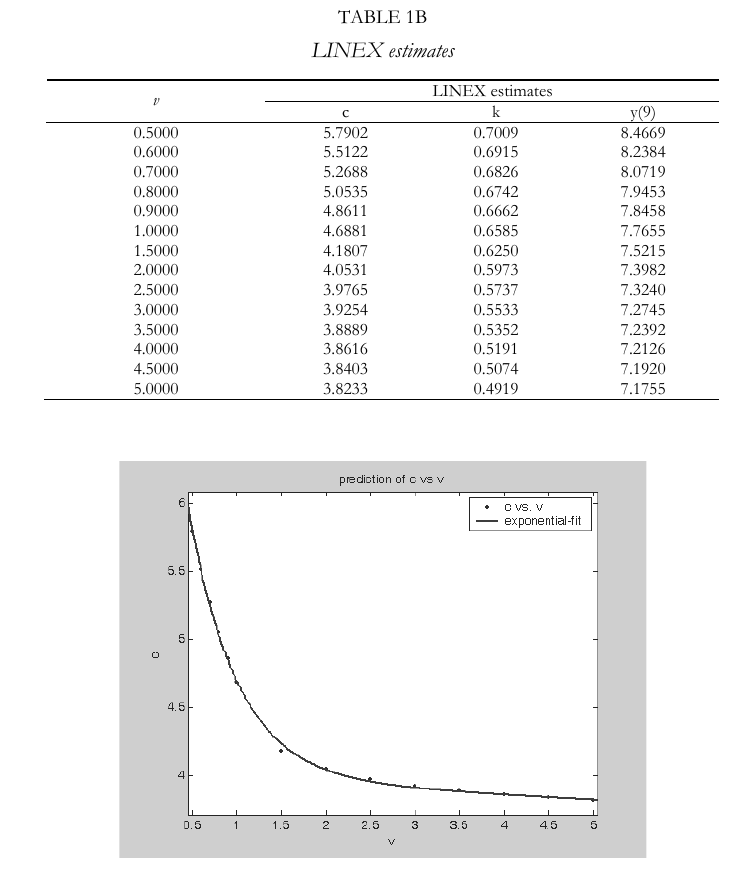
Figure 1 – Graph of prediction of c vs. . v